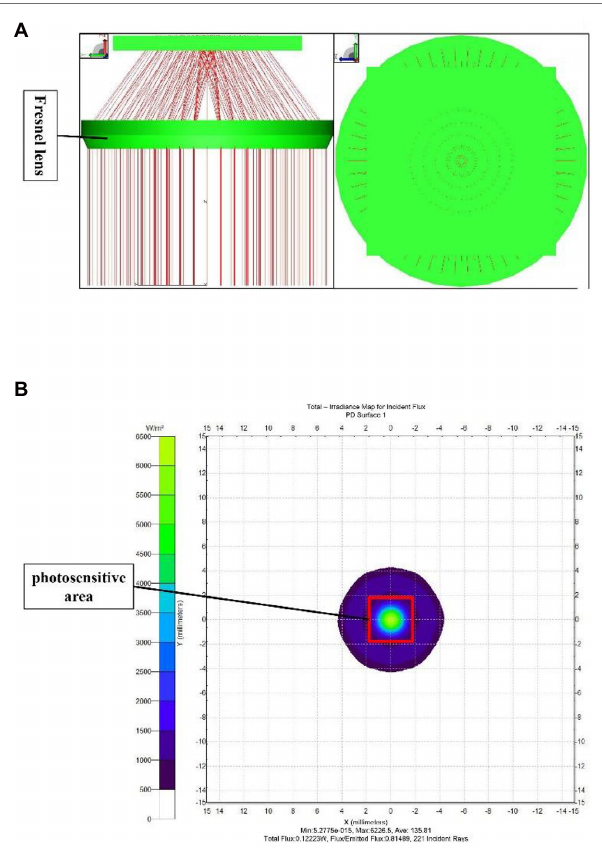
FIGURE 8 | Inductive light.